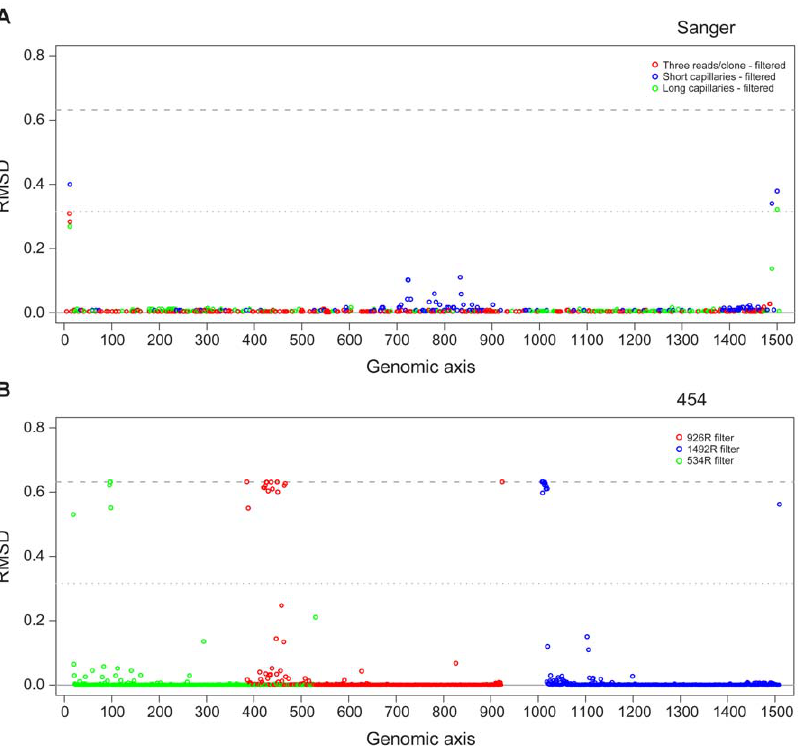
Figure 7. Error by position profiles indicate hotspots for error. To visualize where sequencing errors were concentrated along the length of the 16S sequence for each sequencing technology, a root mean square deviation (RMSD) plot was generated for (A) 3730 sequence and (B) 454 read data. The RMSD plot is a graphical representation of the differences in nucleotide distribution between a reference sequence and the samples of interest, for each position along the length of the reference. This figure shows the results for Neisseria meningitidis specifically, but is representative of the profiles observed for the other strains in the MC.